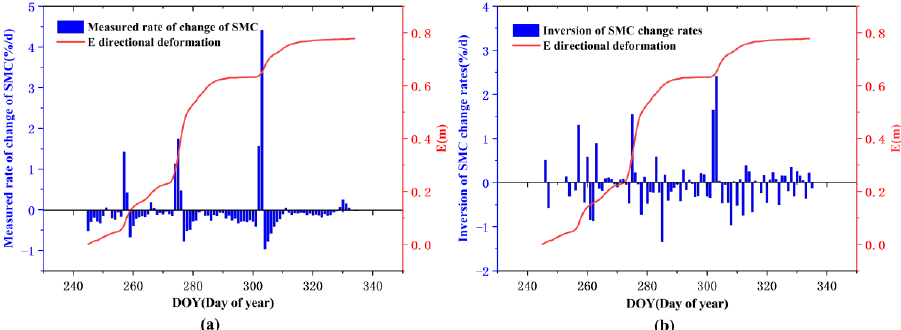
Figure 20. Relationship between deformation and the rate of change of ( a ) measured soil moisture; ( b ) inverse soil moisture.